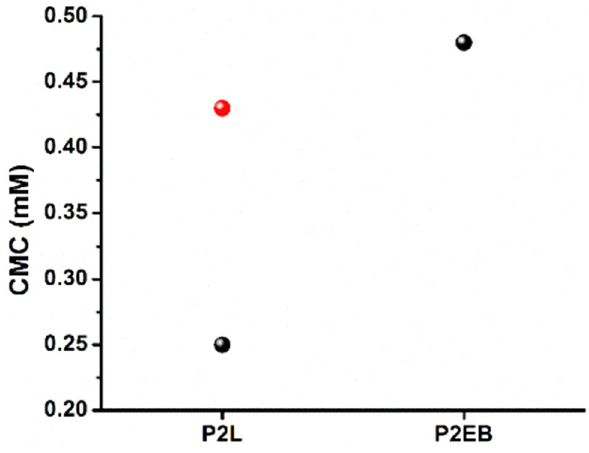
Figure 6. CMC data of P2L and P2EB after 1 day (black balls), and after 4 weeks (red